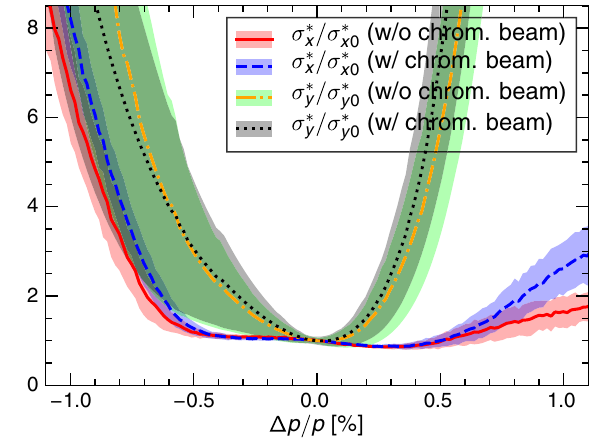
FIG. 8. Momentum bandwidths with fixed and chromatic Twiss parameters, emittances, and dispersions at the extraction for the ultralow β (cid:1) optics. The on-momentum IP vertical beam sizes are 27 . 5 (cid:3) 3 . 2 and 27 . 4 (cid:3) 3 . 1 nm for the two